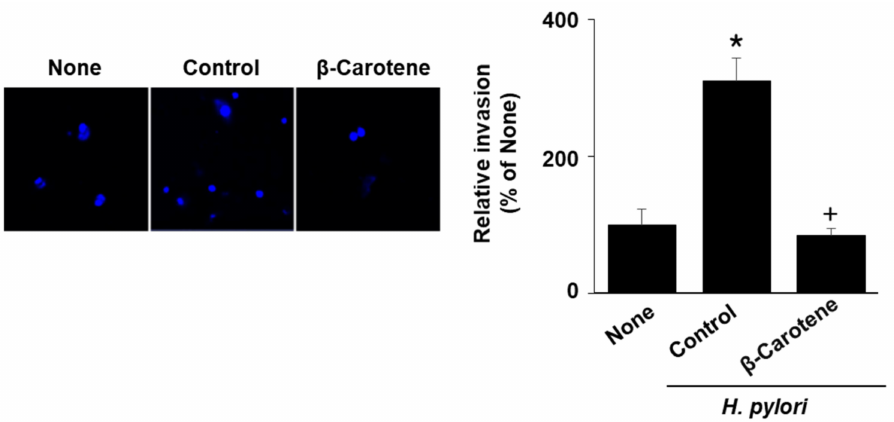
Figure 4. β -Carotene inhibits cell invasion induced by H. pylori in AGS cells. AGS cells were pretreated with β -carotene (0.2 µ M) for 2 h and then infected with H. pylori for 24 h. Invasive cells were measured by staining them on Matrigel-coated filters with 4 (cid:48) ,6-diamidino-2-phenylindole (DAPI) and visualizing them under a confocal laser scanning microscope (left panel). The graph represents the relative percentage of invasive cells (right panel). All data are shown as the mean ± S.E. of three independent experiments. The percentage of invasive cells in none (the cells without any treatment or infection) was set as 100%. * p < 0.05 vs. none (cells without any treatment or infection); + p < 0.05 vs. control (cells with H. pylori infection